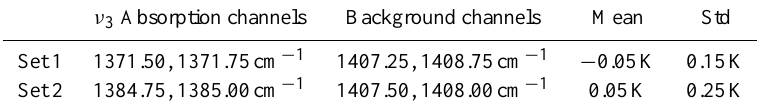
Table 1. Two sets of absorption and background channels used in the calculation of SO 2 abundances. The mean and standard deviation of their brightness temperature differences were calculated on one day with no detectable quantities of SO 2 .